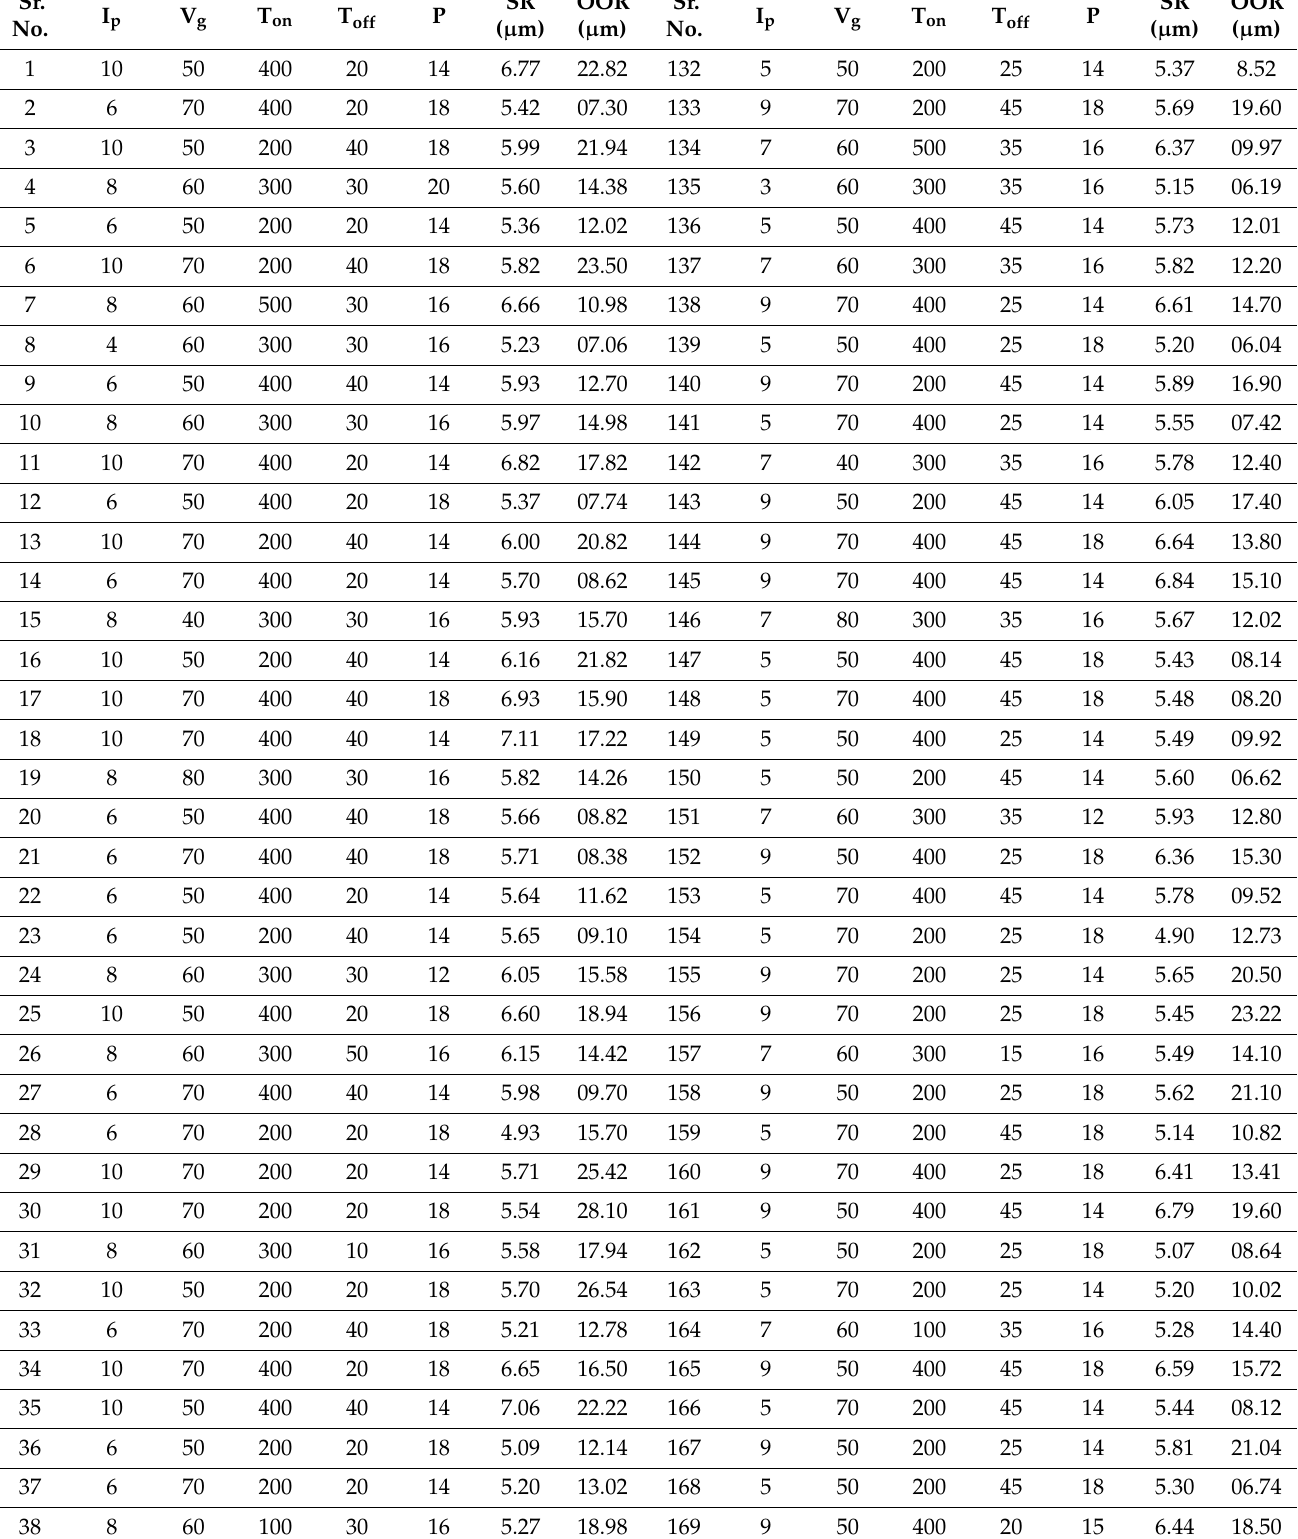
Table A1. Data set for machine learning-based regression